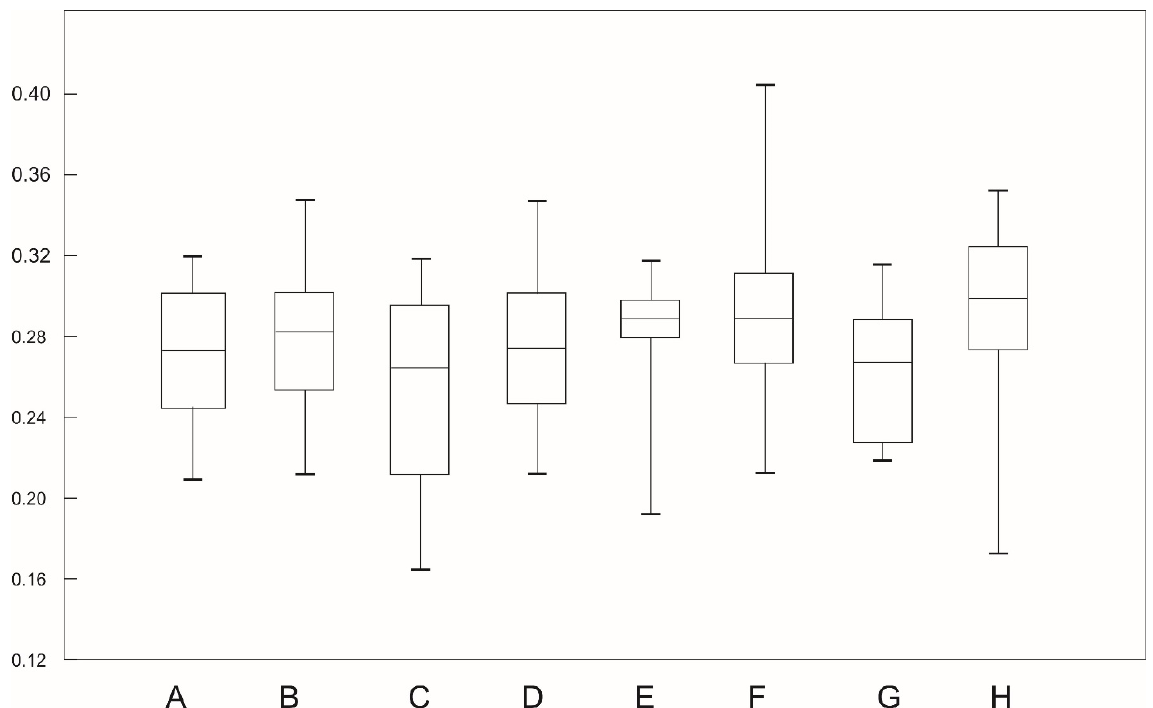
Figure 3. The mean of seed mass in pairs: anthropogenic (A,C,E,G) and natural (B,D,F,H) habitats at different height levels. A,B: 0.01–0.5 m, C,D: 0.51–1.0 m, E,F: 1.01–1.5 m, G,H: 1.51–2.0 m. The at different height levels. A, B: 0.01–0.5 m, C, D: 0.51–1.0 m, E, F: 1.01–1.5 m, G, H: 1.51–2.0 m. differences are not significant (Kruskal–Wallis test, p > 0.05). The differences are not significant (Kruskal–Wallis test, p > 0.05).